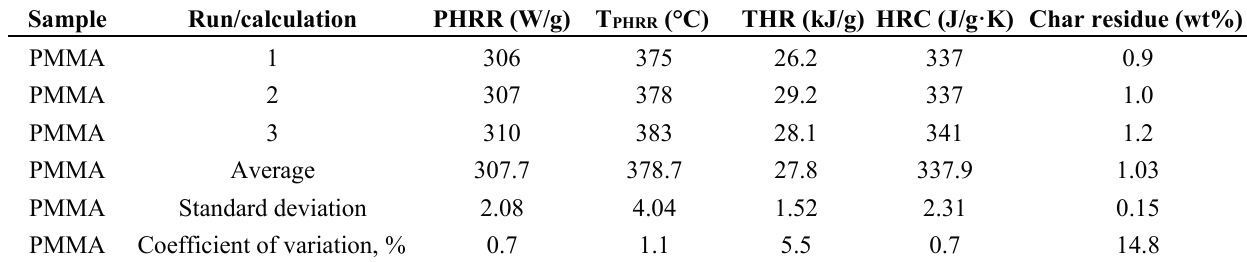
Table 4. The standard deviation and the coefficient of variation of the pyrolysis combustion flow calorimetry (PCFC) measurements for unmodified polymethyl methacrylate